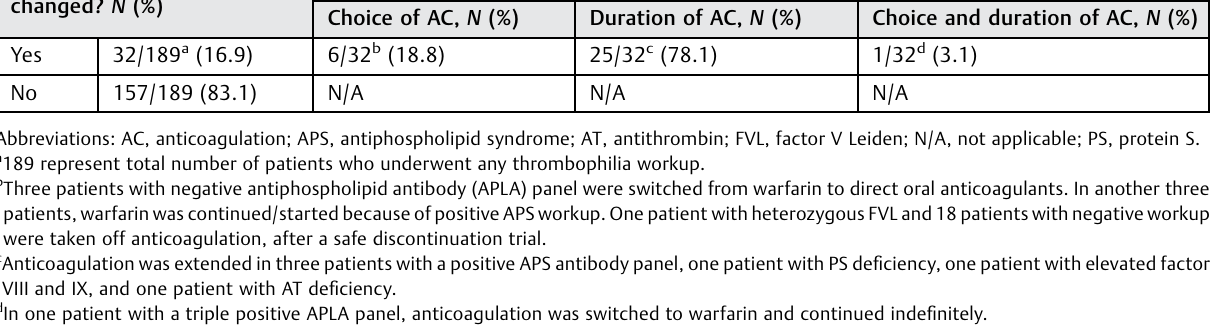
Table 5 Effect of thrombophilia workup on management Was management plan changed? N (%)